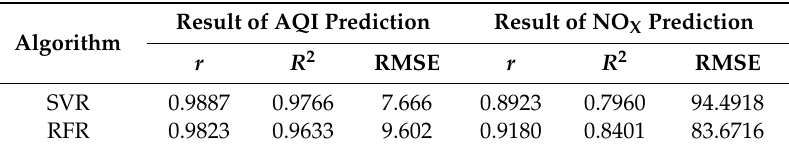
Table 1. The statistical parameters of the experiments for the Air Quality Index (AQI) and total nitrogen oxide (NO X )